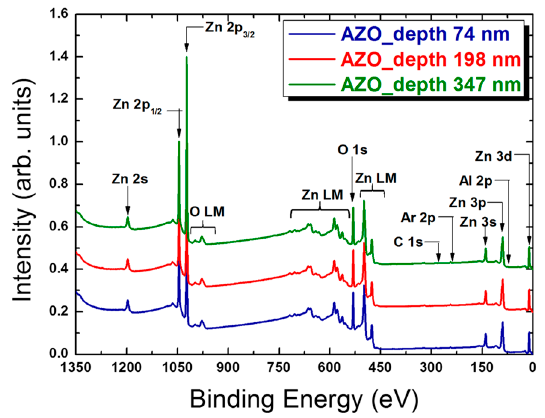
Figure 3. X ‐ ray photoelectron spectroscopy (XPS) wide scans of AZO layers at different depth. Figure 3. X-ray photoelectron spectroscopy (XPS) wide scans of AZO layers at different